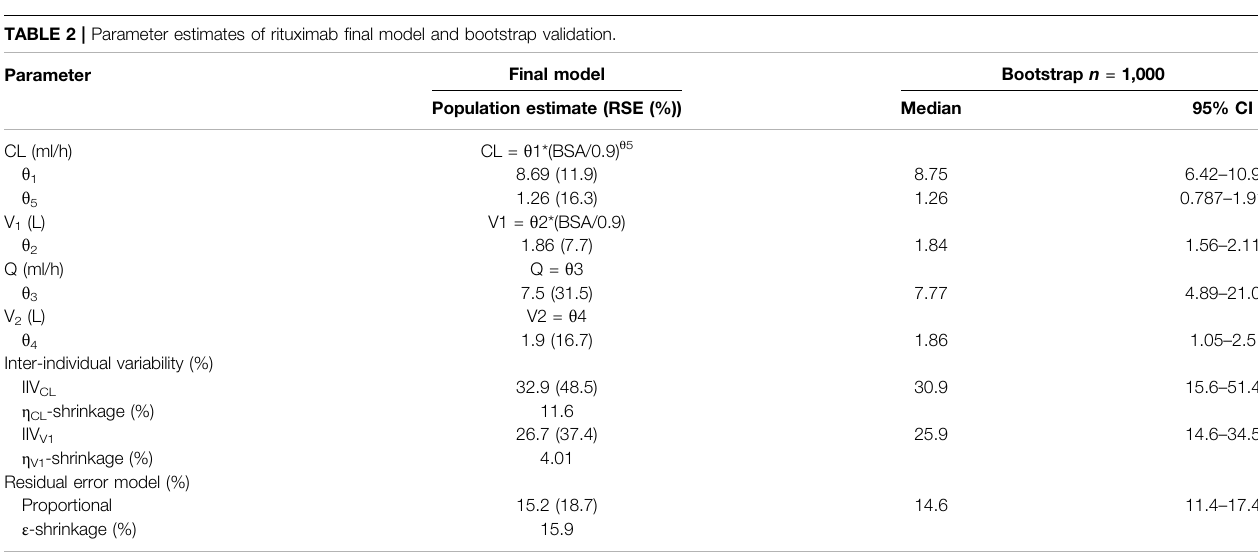
TABLE 2 | Parameter estimates of rituximab fi nal model and bootstrap